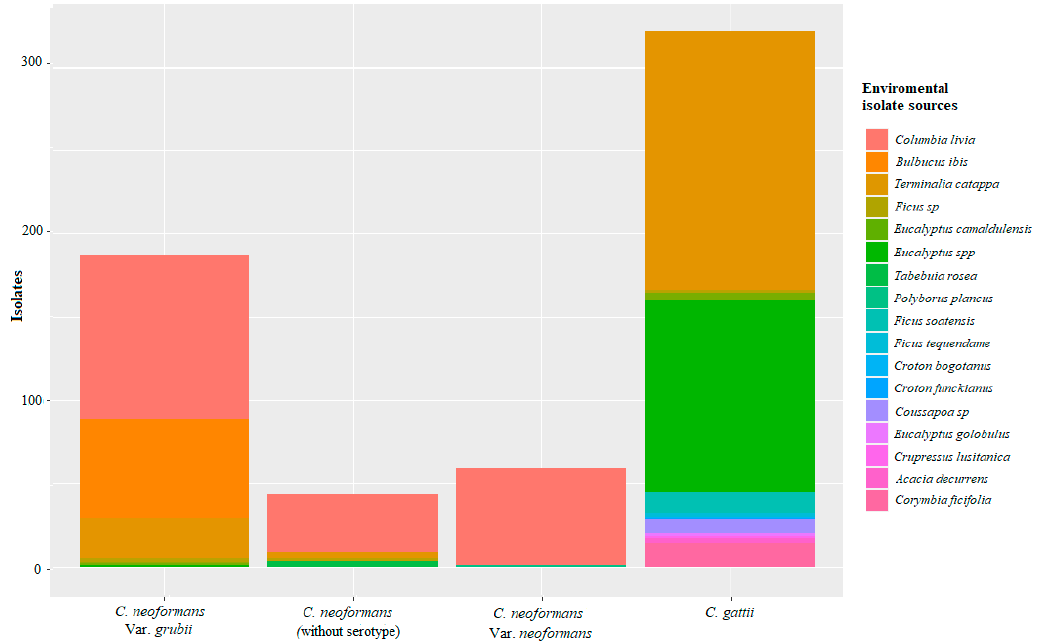
Figure 4. Isolations reported according to their environmental source for the complexes of species of C. neoformans and C. gattii in Colombia. Source: The authors of this study; image created in RStudio.